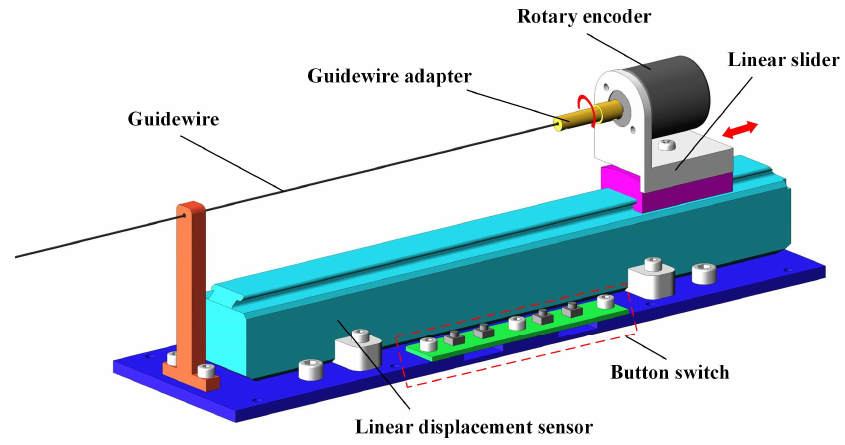
Figure 3. Main components of the master robot.